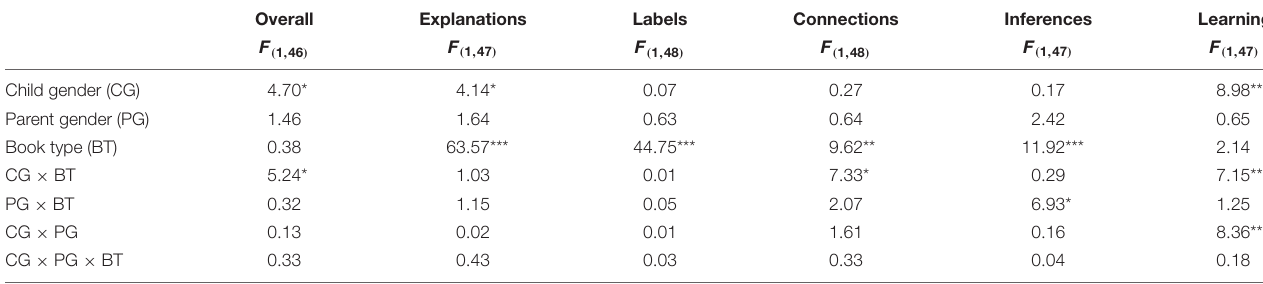
TABLE 4 | Summary of results from linear mixed models. Overall Explanations